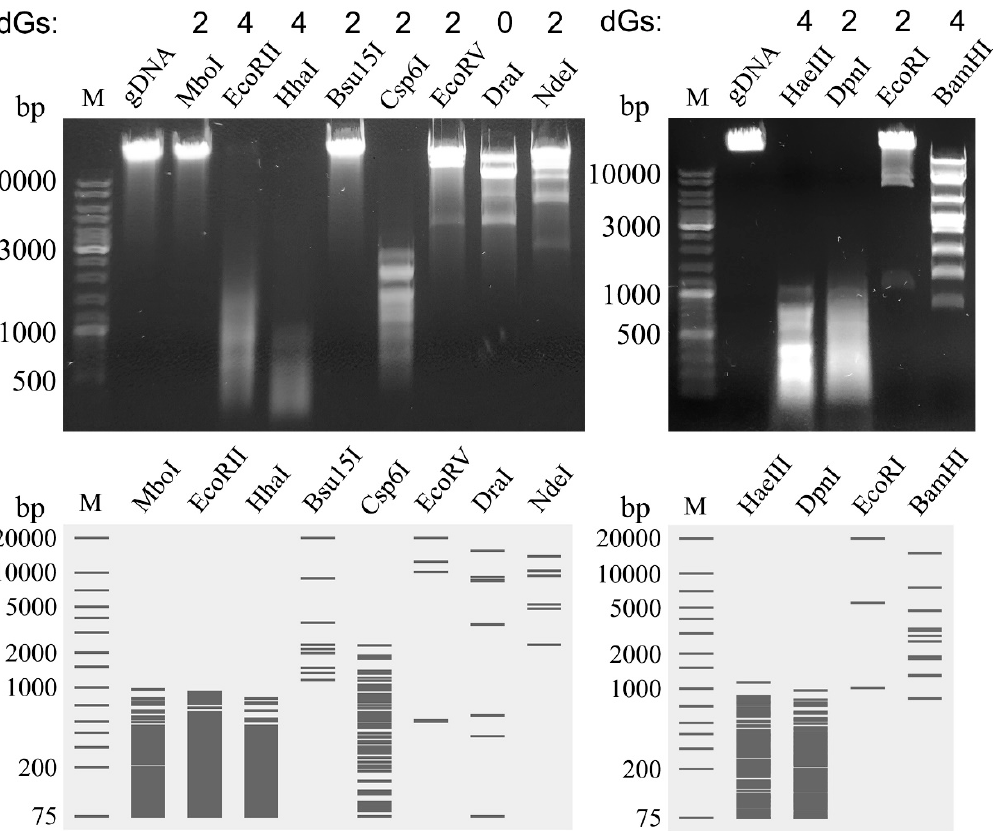
Figure 4. Restriction patterns of phage MED16 genomic DNA by Type II REases. REases are indicated on top of each lane as well as the number of guanine bases (G) in the recognition sequence. The exact number of dADG bases in a particular restriction site is unknown. M—GeneRuler™ DNA Ladder Mix (Thermo Fisher Scientific, Vilnius, Lithuania); gDNA— undigested genomic DNA of MED16. Methylation sensitivity of REases: MboI (Dam methylation-sensitive); EcoRII (Dcm methylation-sensitive); HhaI (CpG methylation-sensitive); Bsu15I (CpG methylation-sensitive, Dam methylation-sensitive); BamHI, Csp6I, DpnI, DraI, EcoRI, EcoRV, HaeIII, NdeI (not Dam methylation-sensitive, not Dcm methylation-sensitive, not CpG methylation-sensitive). Below the gel is the representation of the expected restriction pattern.